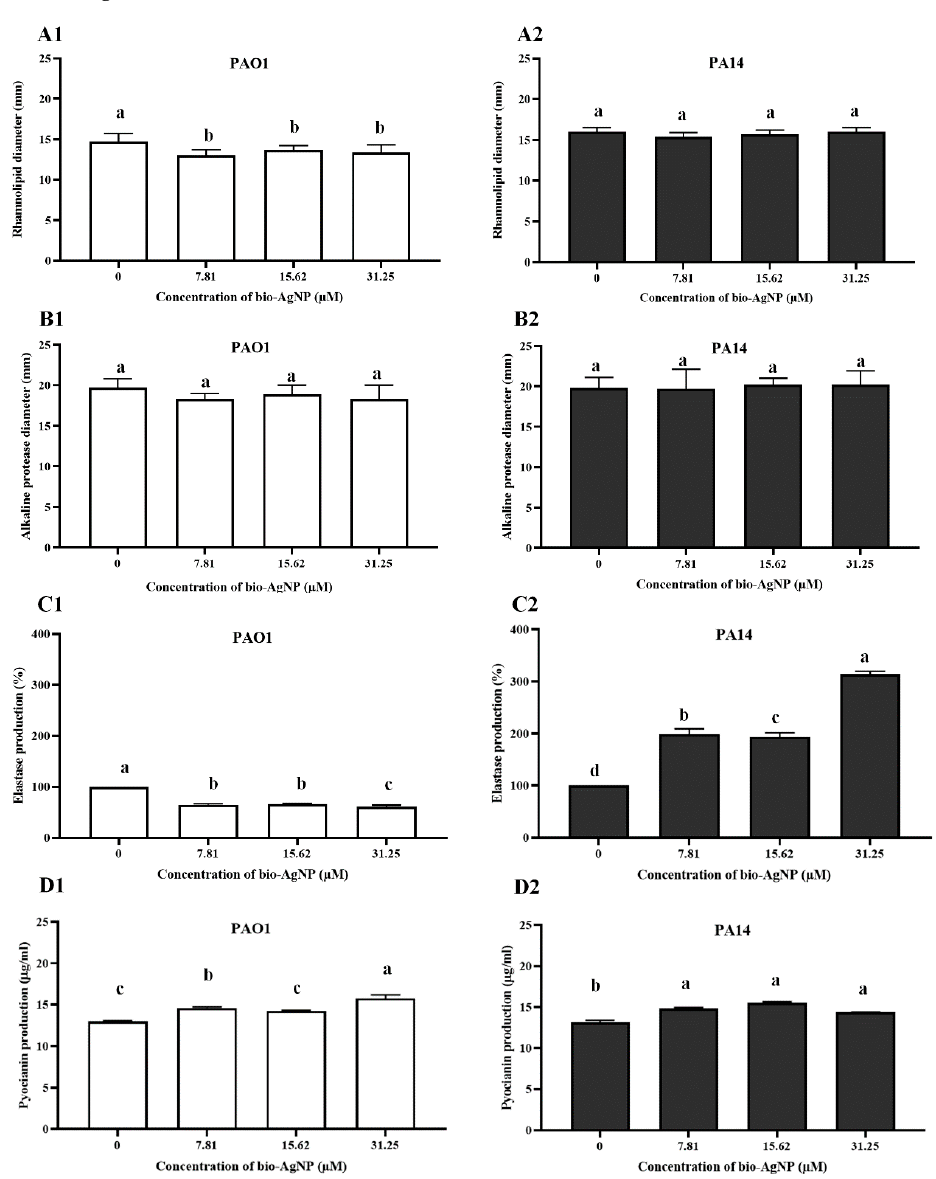
Figure 3. Effect of bio-AgNPs on virulence factors of Pseudomonas aeruginosa PAO1 and PA14. Rhamnolipid production in ( A1 ) PAO1 and ( A2 ) PA14. Alkaline protease production in ( B1 ) PAO1 and ( B2 ) PA14. Elastase B production in ( C1 ) PAO1 and ( C2 ) PA14. Pyocyanin production in ( D1 ) PAO1 and ( D2 ) PA14. Results are expressed as mean ± standard deviation (n = 3). a–c Tukey’s honestly significant difference test at p <